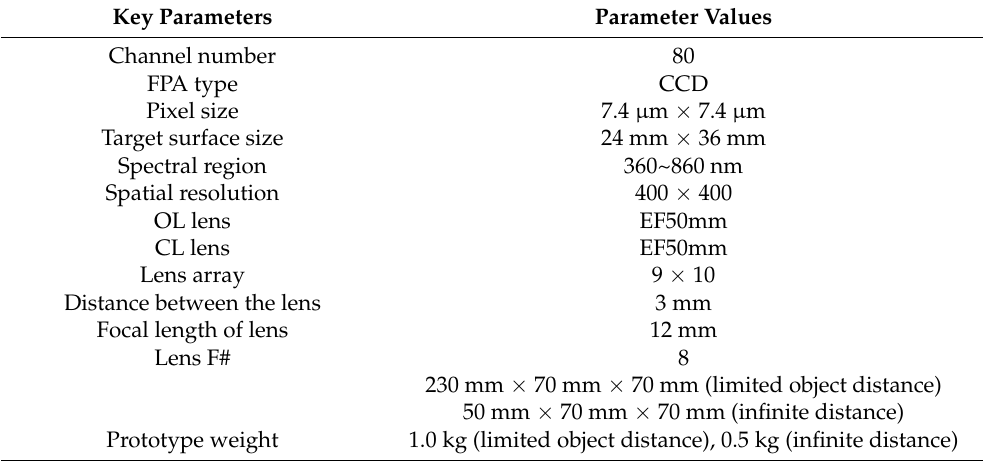
Table 8. Specifications of the system.